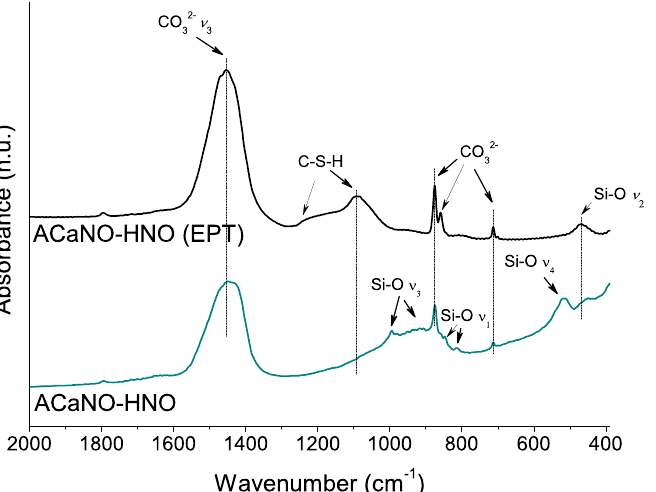
Figure 9. FT-IR analysis of hydrated BECs: without post-synthesis treatment (ACaNO-HNO), and after EPT (ACaNO-HNO (EPT)).